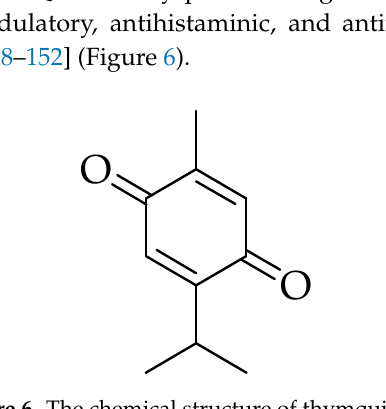
Figure 6. The chemical structure of thymquinone.